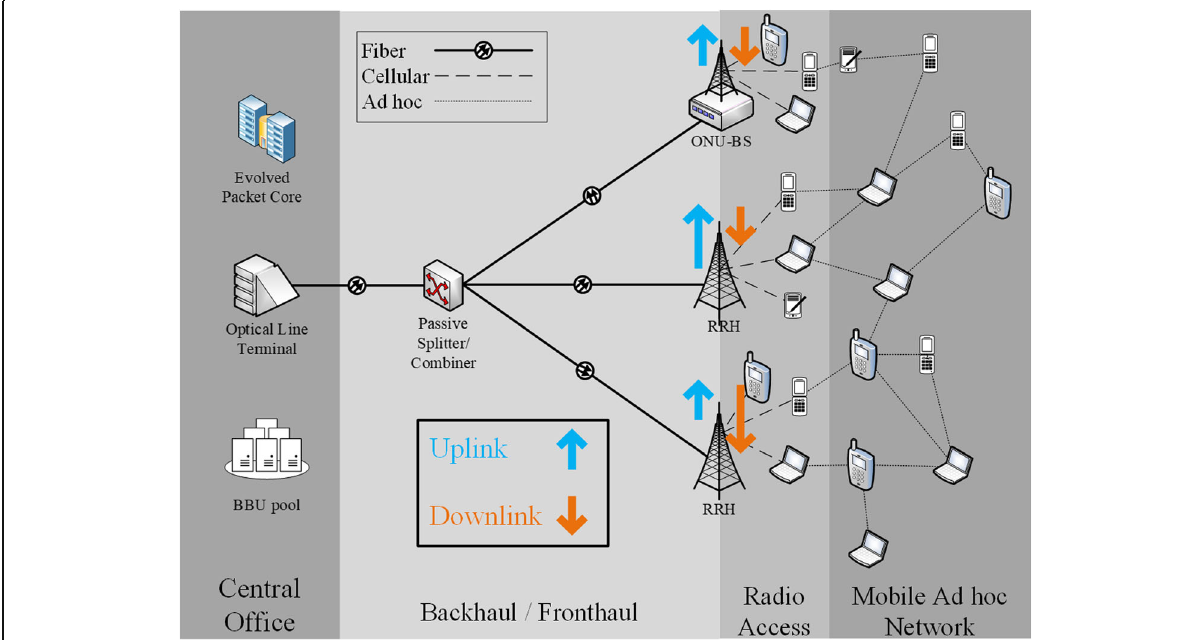
Fig. 6 Traffic engineering paradigm by adjusting the uplink-to-downlink ratio in the fronthaul network to support traffic engineering in the MANET domain